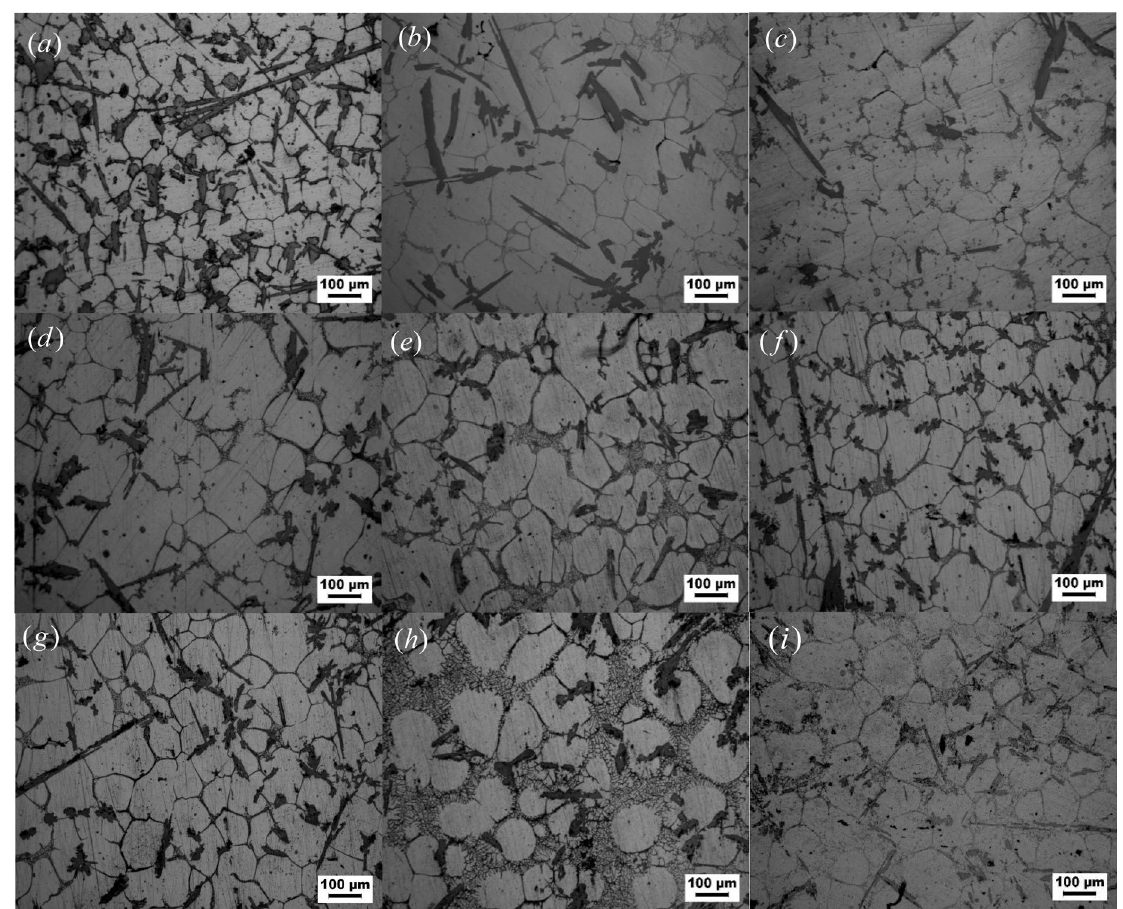
Figure 1. Microstructure of Al–Fe–Cu alloy quenched water after semisolid heating for different temperatures and times. ( a ) At 620 °C for 5 min, ( b ) at 630 °C for 5 min, ( c ) at 640 °C for 5 min, ( d ) at 620 °C for 30 min, ( e ) at 630 °C for 30 min, ( f ) at 640 °C for 30 min, ( g ) at 620 °C for 60 min, ( h ) at 630 °C for 60 min, ( i ) at 640 °C for 60 min.